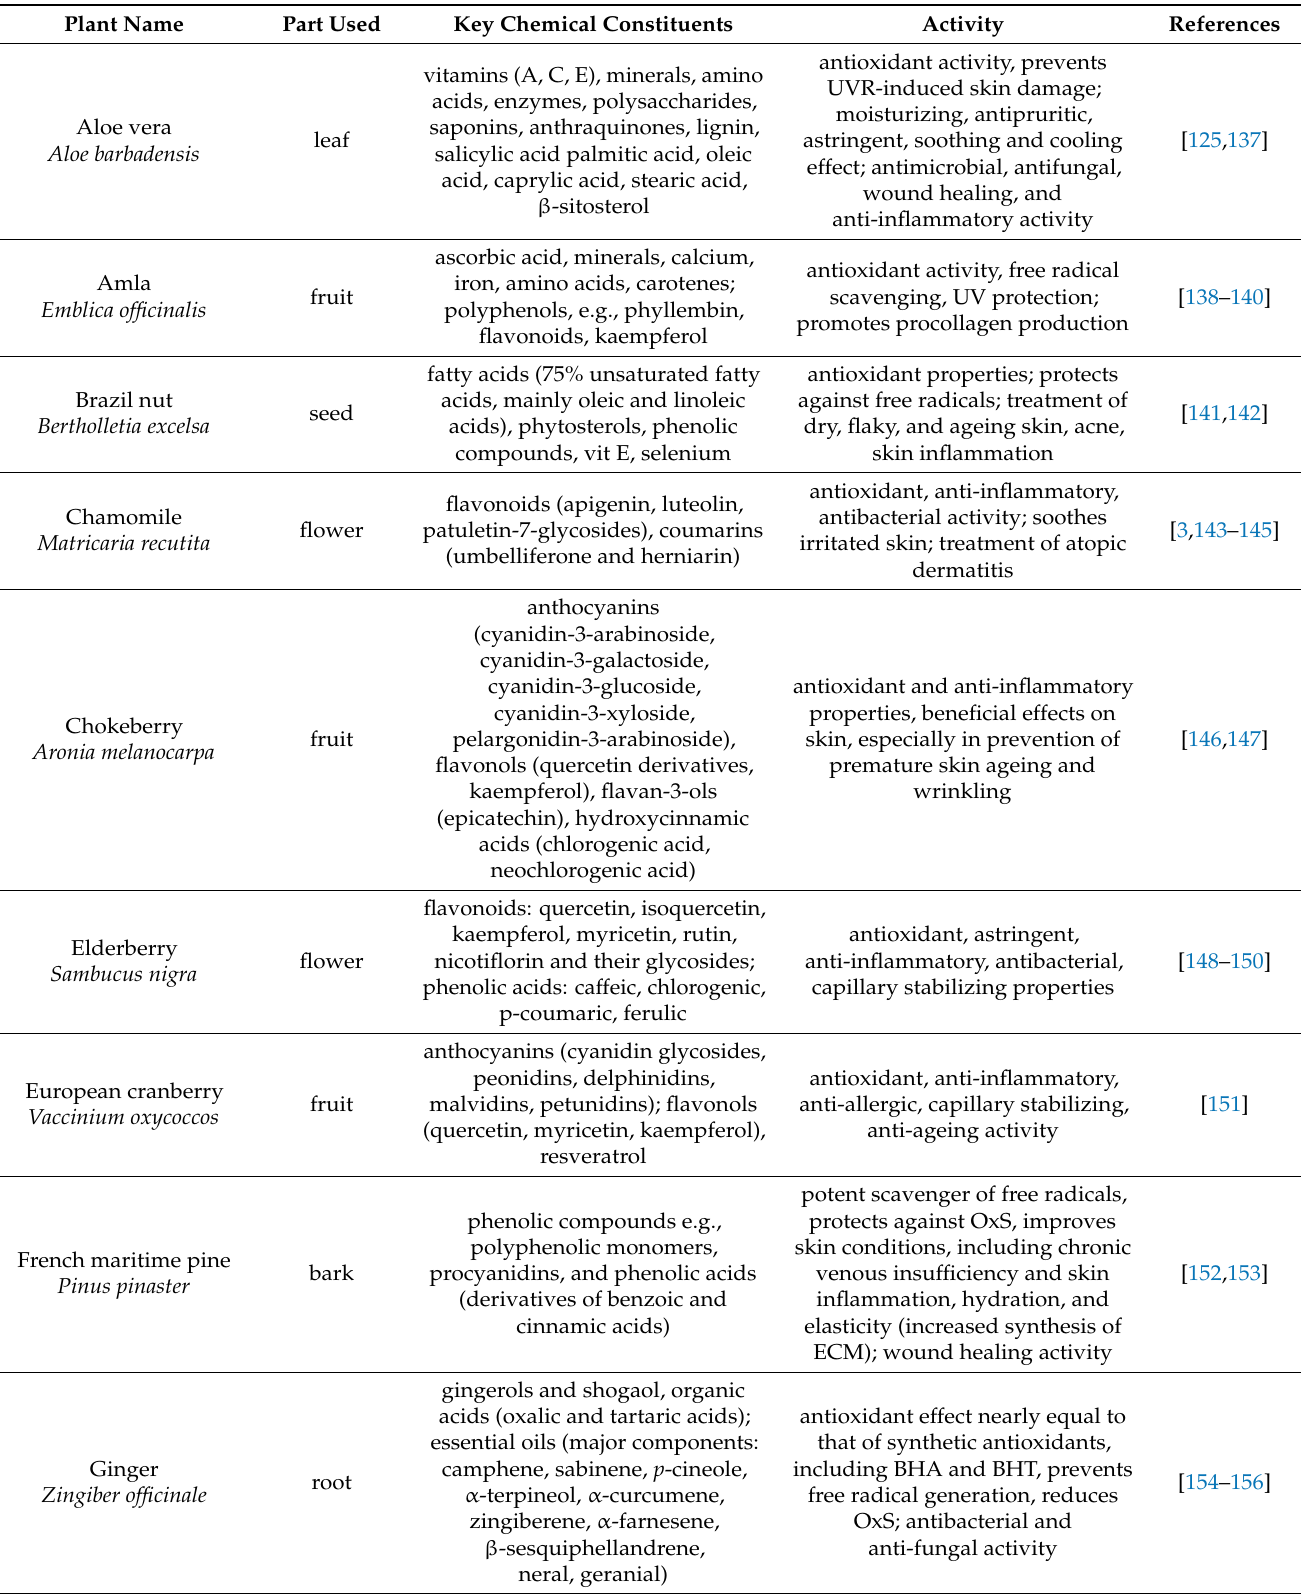
Table 6. Selected antioxidants of plant origin, some of their common chemical constituents, and their importance for